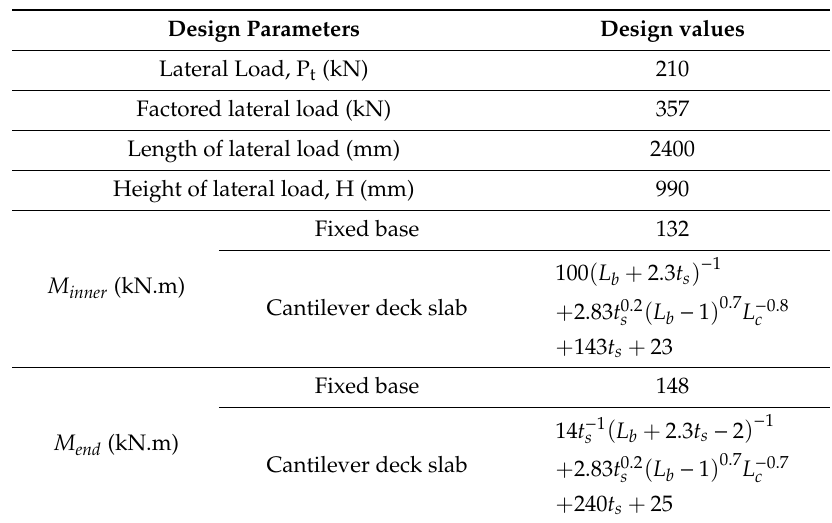
Table 4. Factored design moments at the barrier–deck interface [18].